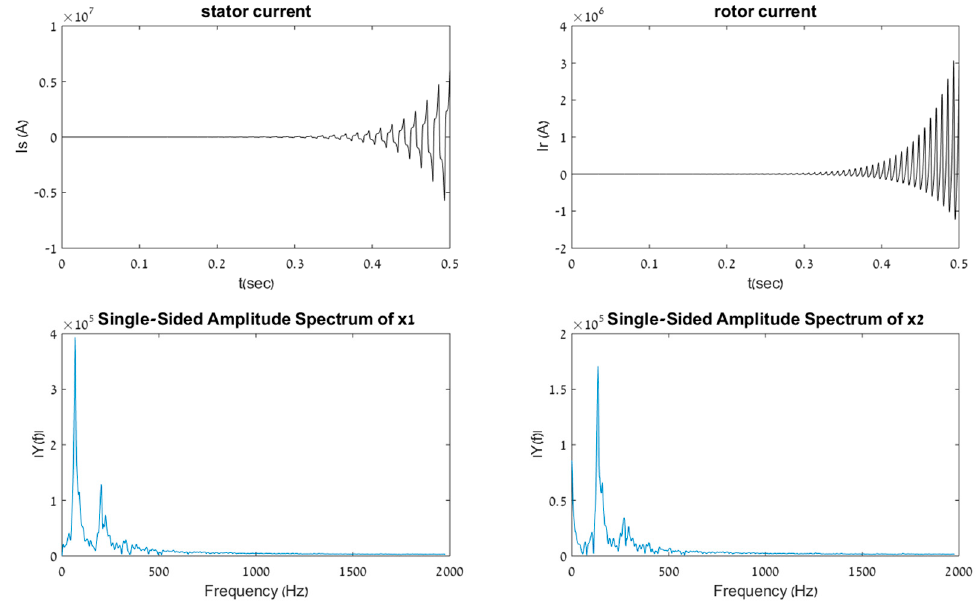
Figure 16. Adding rotor currents and FFT (Fast Fourier Transform). L s = 0.22 H. At the boundary, L s = 0.21 H exactly, the IG is marginally stable, as evidenced by the simulation when run for 0.5 s (Figure 17).